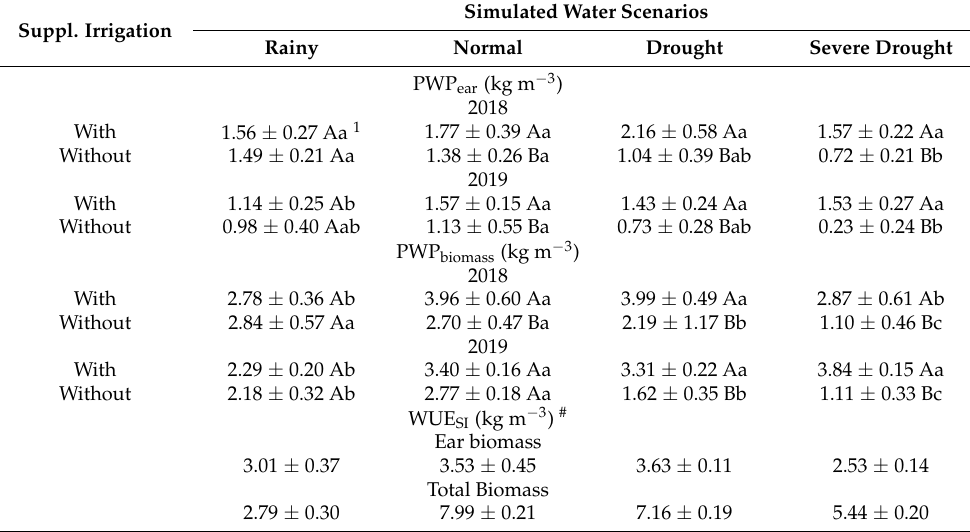
Table 1. Physical water productivity (PWP) based on dry ear production (PWP ear ), total dry biomass production (PWP biomass ), and supplemental irrigation efficiency (WUE SI ) in maize as a function of water scenarios with and without supplemental irrigation with brackish water (ECw = 4.5 dS m − 1 ). Simulated Water Scenarios Suppl. Irrigation Rainy